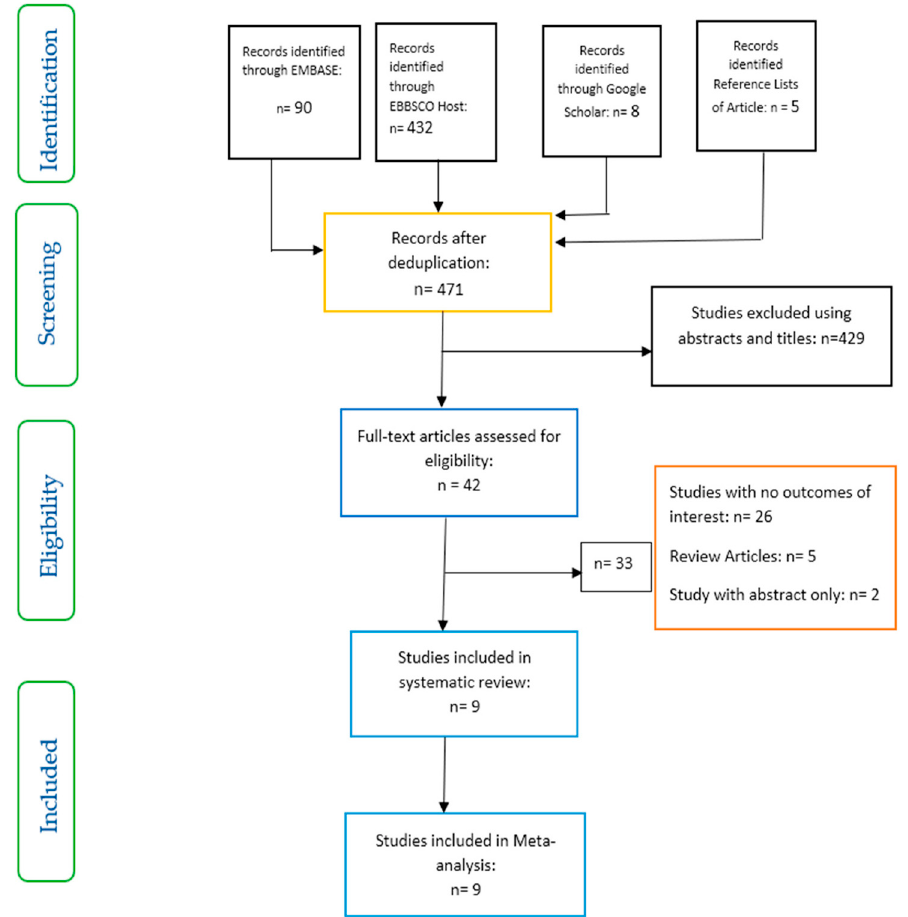
Figure 1. Preferred Reporting Items for Systematic Reviews and Meta-Analyses (PRISMA) flow chart on selection and inclusion of